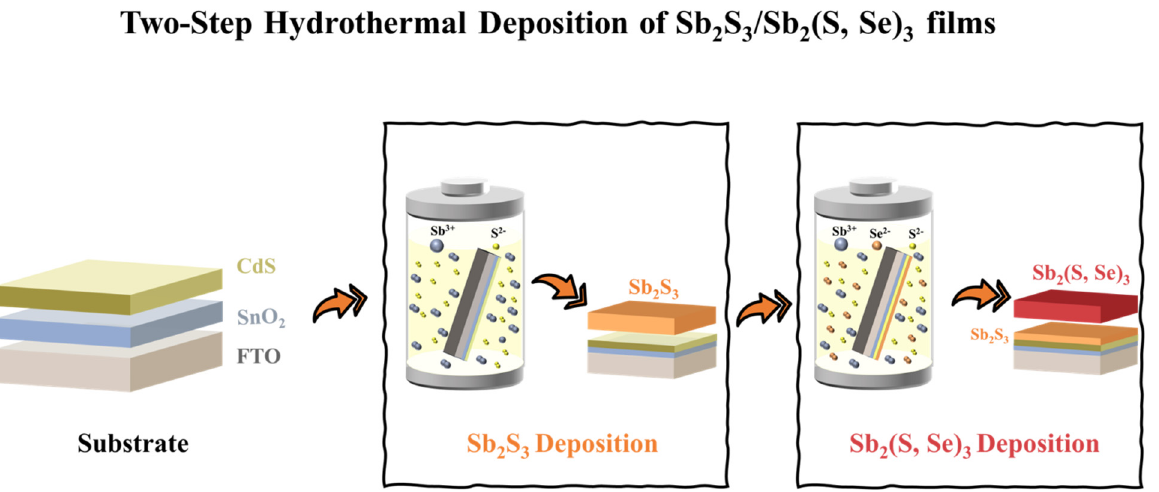
Figure 1. Schematic illustration of the two-step hydrothermal deposition of Sb 2 S 3 /Sb 2 (S, Se) 3 films. The Sb 2 S 3 layer was first deposited on FTO/SnO 2 /CdS substrate followed by the deposition of the Sb 2 (S, Se) 3 layer.